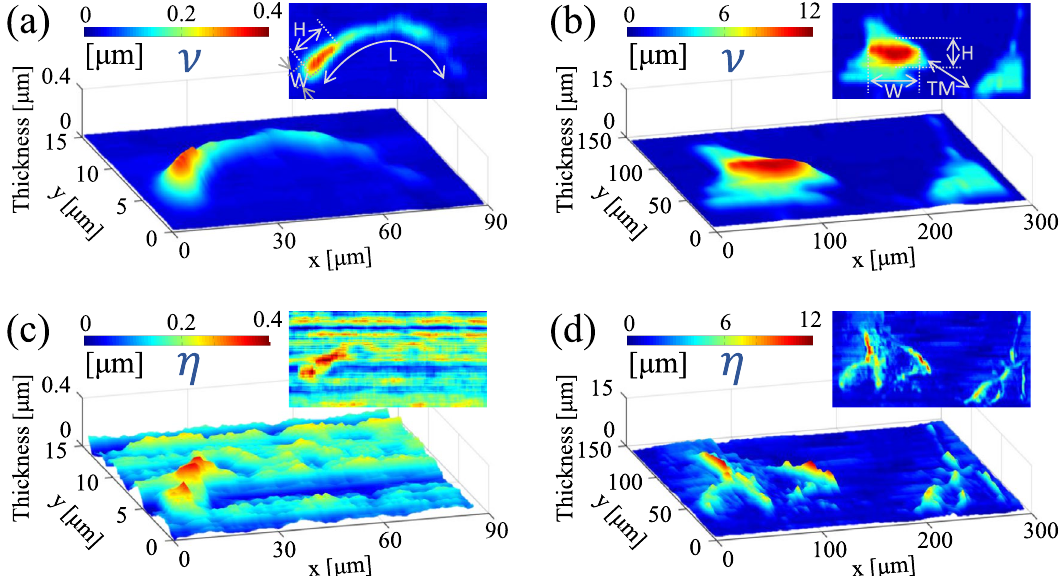
Figure 5. Experimental results for neurons (U87) and bovine sperm cells; Reconstructed 3D images of a dense sample of neurons obtained through (a) V and (b) η parameters. Reconstructed 3D images of a sperm cell through (c) V and (d) η parameters. The insets are the cross-sectional profiles along AB and A ′ B ′ lines depicted in panels (c,d) , respectively. In panels (a,b) the cells typical dimensions are